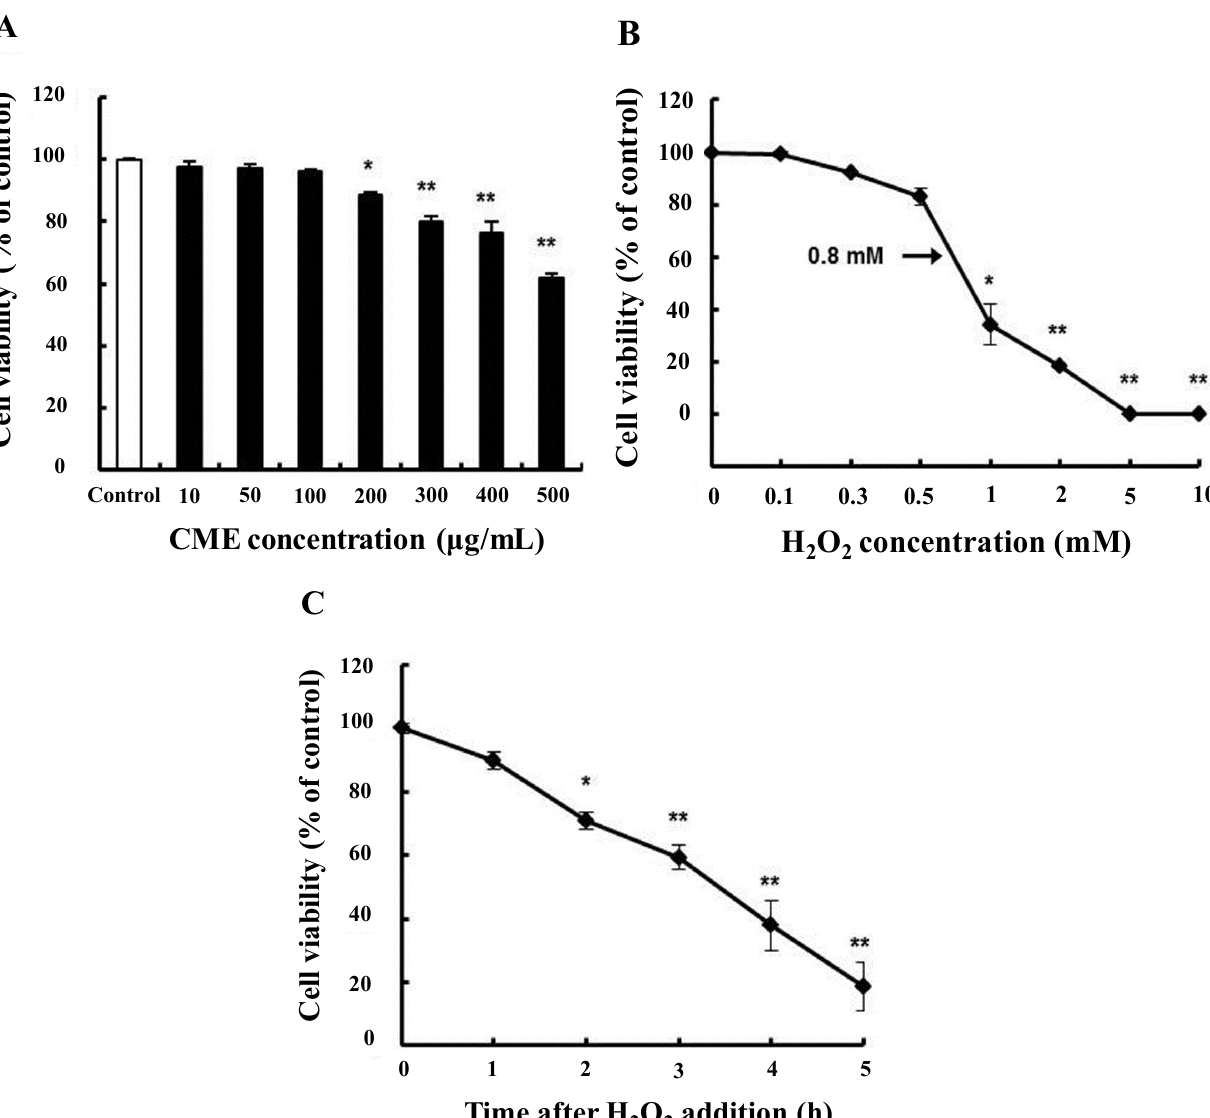
Figure 2. Viability of human dermal fibroblasts (HDFs) treated with CME or H 2 O 2 . ( A ) Cell viability of HDFs treated with various concentration of CME; ( B ) cell viability of HDFs treated with various concentrations of H 2 O 2 for 3 h; ( C ) cell viability of HDFs treated with different exposure time with 0.8 mM H 2 O 2 . Cell viability was determined using the MTT assay. Data represent the mean ± SE of three independent